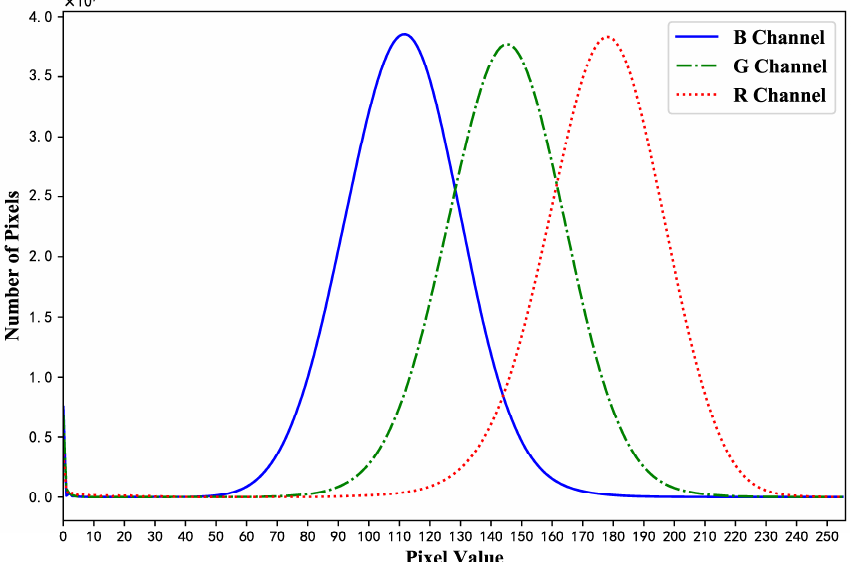
Figure 9. The numbers of pixels with each value in the R, G, and B channels.